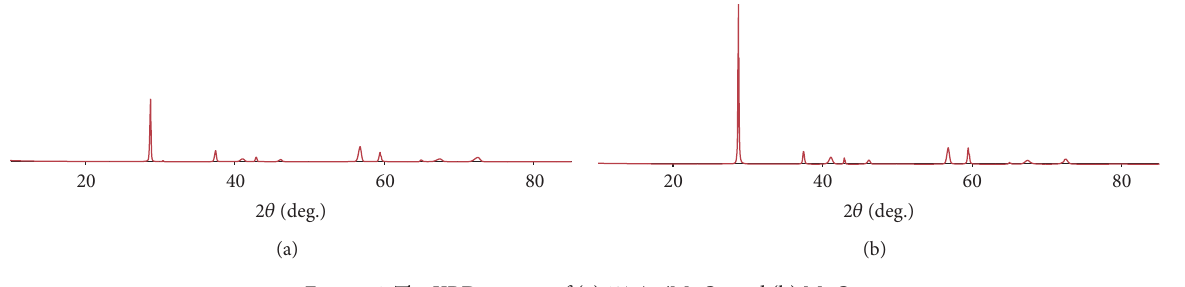
Figure 1: The XRD pattern of (a) 1% Au/MnO 2 and (b) MnO 2 . Table 2: Effect of bimetal on 2-hexenal oxidation.